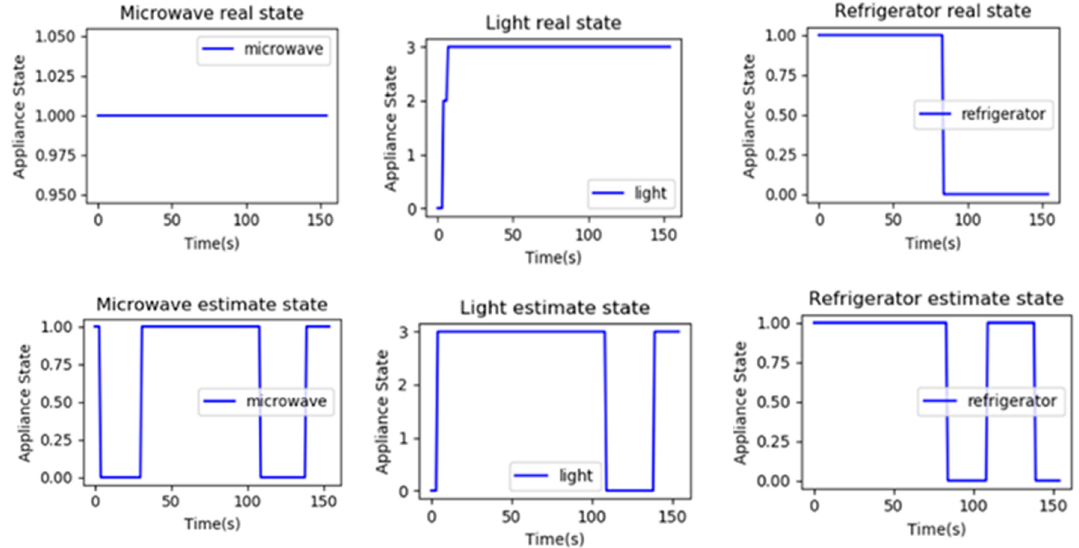
Figure 8. Comparison between appliances’ real and estimate states.